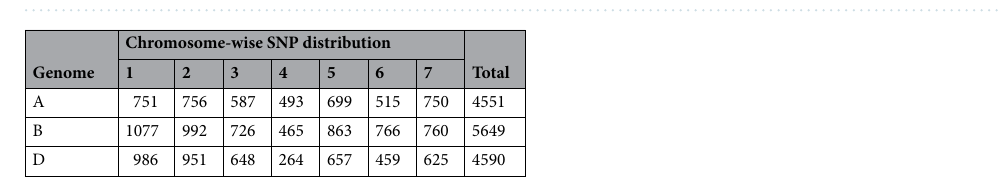
Table 2. Sub-genome and chromosome-wise distribution of SNP markers in the GWAS panel.